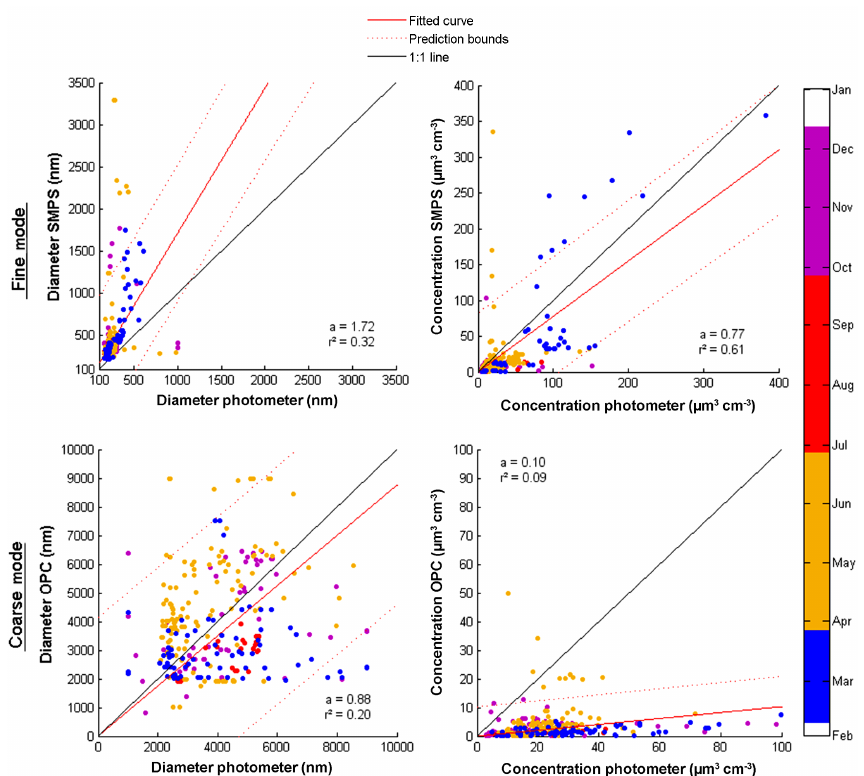
Figure A1. Scatter plots of volume PSD parameters from in situ and sun photometer measurements for both fine (top panels) and coarse (bottom panels) modes in function of season. Left panels represent particle diameters comparison and right panel concentrations. Full red line represents the linear fit and dotted red lines the 5th and 95th percentiles. The black line is the 1 : 1 line.